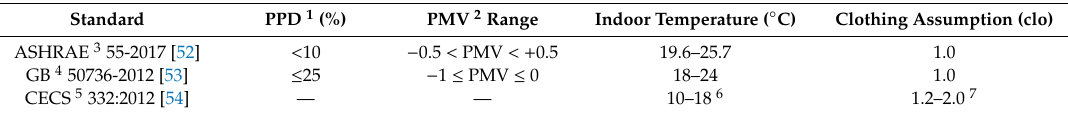
Table 2. Recommended indoor temperature and assumed conditions for winter (heating season) in three